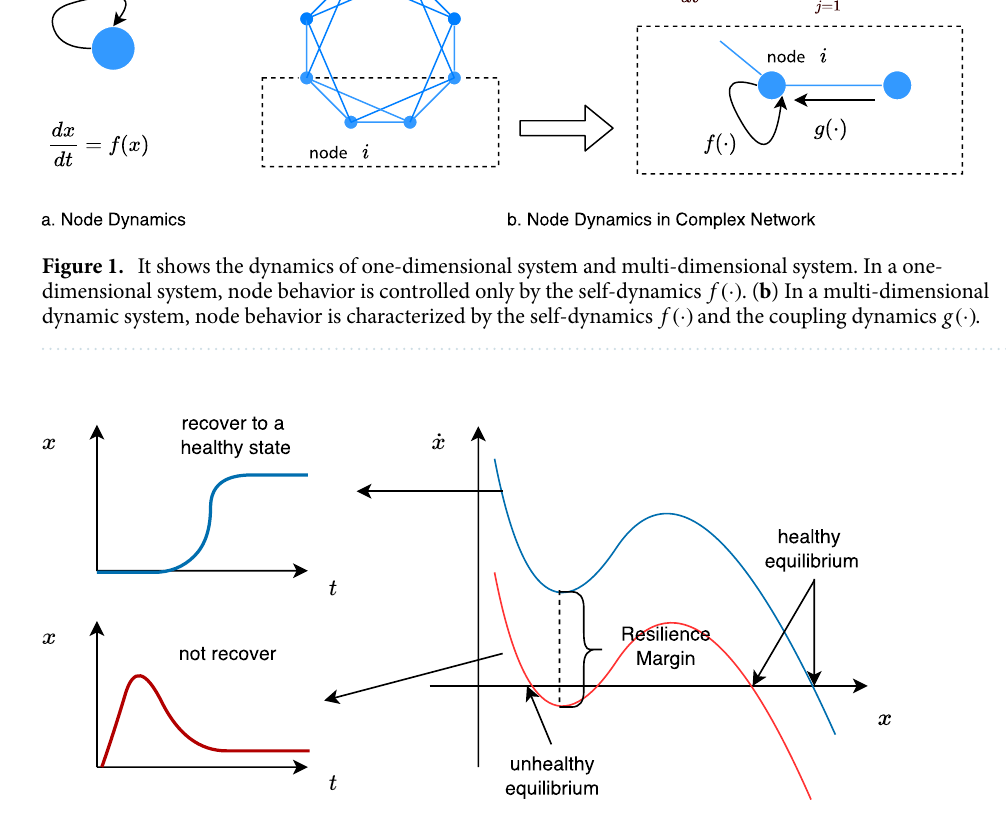
Figure 2. Red line describes a system with more than one stable equilibrium (healthy one and unhealthy one both exist). The system in this situation will remain in a low-level state. The blue line describes a system with only one stable equilibrium, and the system will recover to a high-level state at last. When there exists an unhealthy equilibrium, the system loses resilience. This picture shows the ability of the system to recover to the original state from an undesirable state. The resilience margin shows the ability of the system to withstand the perturbation. If the local minimum value is much larger than 0, the system can withstand more perturbations and keeps resilient. However, if the local minimum value is close to 0, small perturbation may cause the lose of